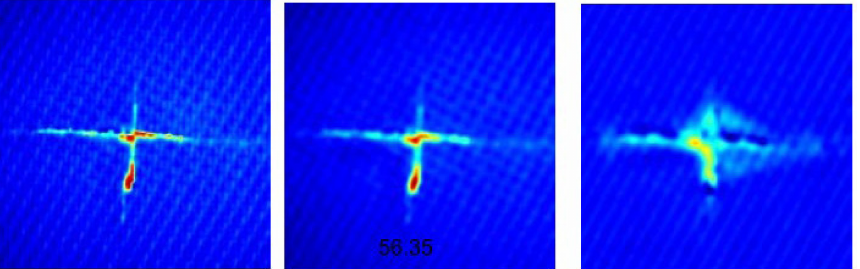
Figure 14. Thermographic images of the back face of panel 10: thermographic image ( left-hand side ), TSR image ( centre ), and second derivative ( right-hand side ).